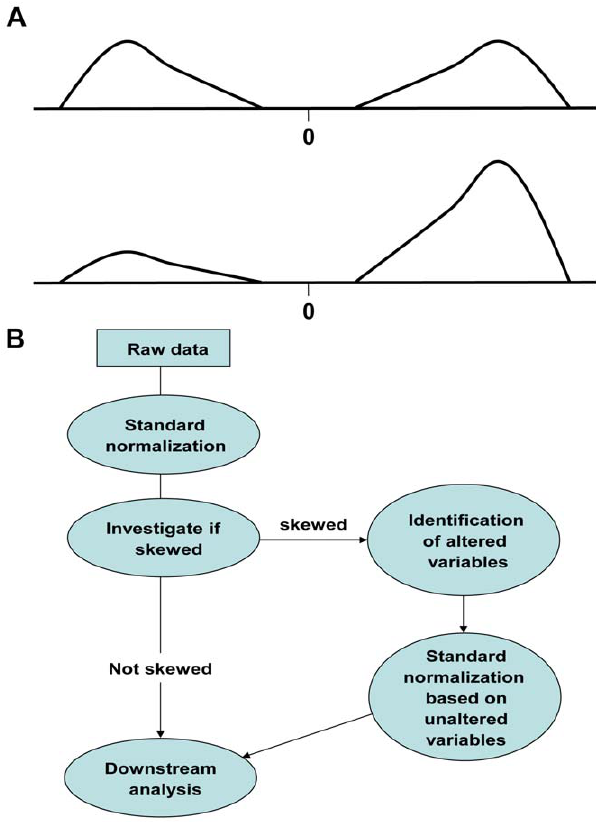
Figure 1. Skewed experiments and workflow. (A) The distribution of the true log-ratios of the altered variables in a non-skewed (upper) and a skewed (lower) experiment. Here an experiment with samples from a treatment and a reference population is considered and the true log-ratios are the expected value of the variables’ log-ratios in the absence of any type of technical variation. (B) Our suggested workflow when analyzing data from high-dimensional experiments. Here the raw data is pre-processed and some kind of standard normalization is applied ( e.g. quantile or MA-normalization). The normalized data is used to determine whether the experiment is skewed or not. For skewed experiments, a hidden Markov model is used to identify altered variables and then a standard normalization based on unaltered variables is used to normalize the data.